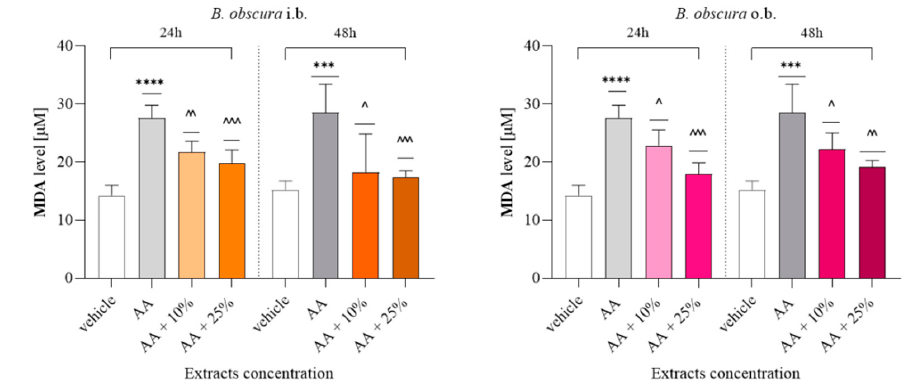
Figure 6. Assessment of malonic dialdehyde (MDA) release from 24 h and 48 h incubation of L929 cell line with 10% and 25% extracts. Data presented as the means ± SD; *** p < 0.001, **** p < 0.0001 vs. vehicle group; ˆ p < 0.05, ˆˆ p < 0.01, ˆˆˆ p < 0.001 vs. AA group; Tukey’s test. Abbreviations: i.b., inner bark; o.b., outer bark; AA, acetaldehyde (positive control).